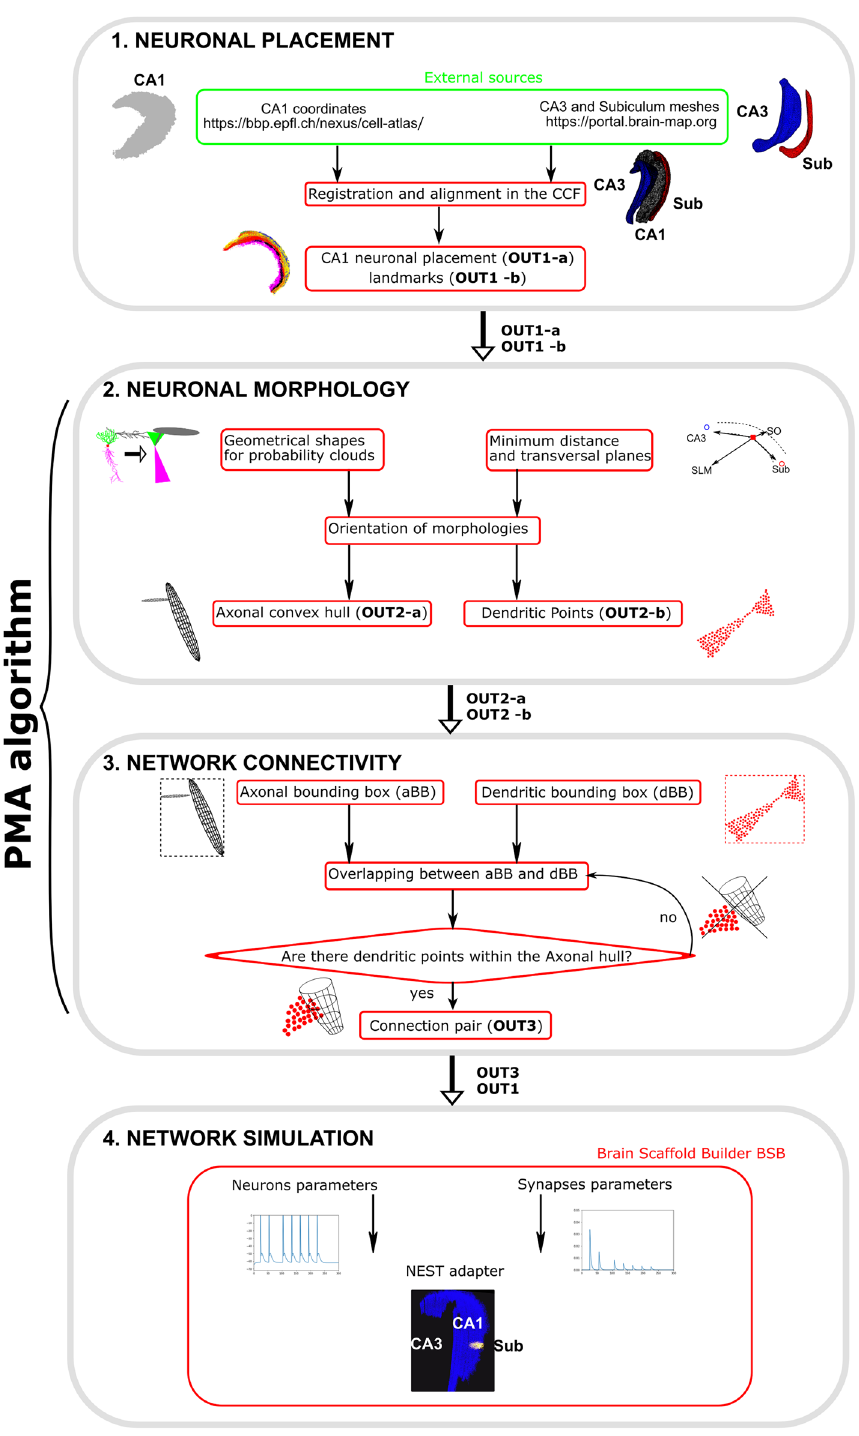
Figure 1. Workflow for the generation of network simulation of CA1 hippocampus. Gray boxes represent the adopted procedural blocks. Red boxes represent computational functions. Green box represents non elaborated data obtained from public repositories (external sources). (1) Neuronal placement: Cell coordinates have been downloaded from the BBP atlas and landmarks have been obtained as meshes from Allen database. 3D coordinates have been assigned to excitatory (2) and inhibitory (11) classes according to their position in CA1 layers (see Fig. 2) and have been aligned with meshes in the CCF to generate the first 2 outputs (OUT1-a,b). (2) Neuronal morphologies: Geometrical shapes have been generated by analyzing morphological databases providing dendritic and axonal features. Neurons have been oriented according to their relative position within the hippocampus and by using CA3, Subiculum and CA1 layers as landmarks to generate axonal convex hulls (OUT2a) and dendritic point clouds (OUT2b). (3) Network connectivity; Bounding boxes for axons and dendrites were generated to calculate the potential intersections of every axon with all dendrites. An iterative algorithm calculated the intersections of every axonal hull only with neurons with overlapping dendritic bounding boxes. Connection pairs (OUT3) were generated when at least one dendritic point was included into the axonal hull. (4) Network simulation. Neuronal placement and connection pairs were loaded into the BSB python module which generated the adapter for the NEST simulator to run the simulation. The PMA algorithm is represented by blocks 2 and